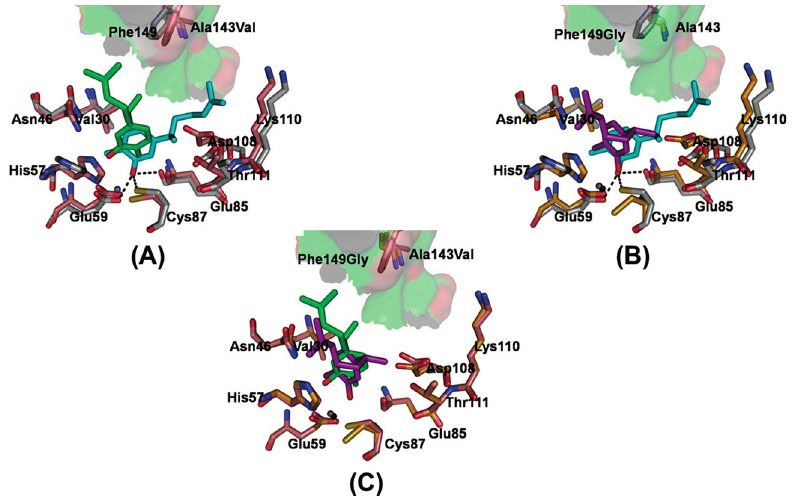
Figure 4. A superimposition of structures of the mutants relative to wild type complex. Representative structures of the mutants ( A ) A143V and ( B ) F149G aligned to the WT structure for a 20-ns snapshot taken from the complex trajectories. The carbon atoms of both mutants are colored salmon (A143V) and bright orange (F149G), and the carbon atoms of the WT system are colored light gray. The carbon atoms of xanthorrhizol are colored green (A143V) and purple (F149G). Xanthorrhizol and amino acid residues are displayed as sticks; ( C ) Representative structure of the A143V mutant aligned to the F149G structure. The xanthorrhizol (cyan) and the involved amino acid residues (light gray) are displayed as sticks in the structure of the xanthorrhizol and wild-type Ec TadA complex. The hydrogen bonds are displayed as black dashed